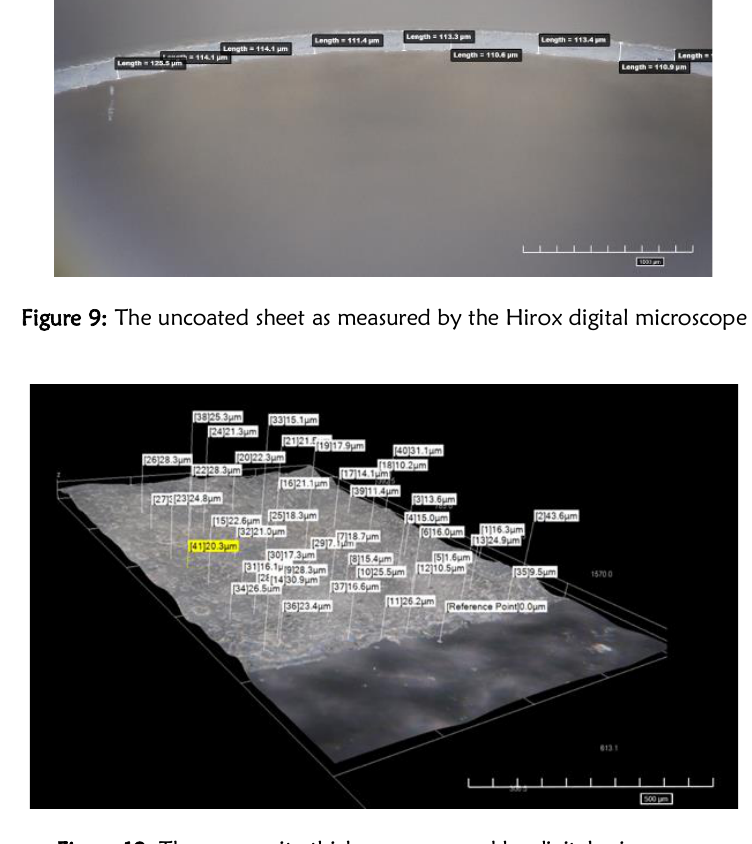
Figure 10: The composite thickness measured by digital microscope